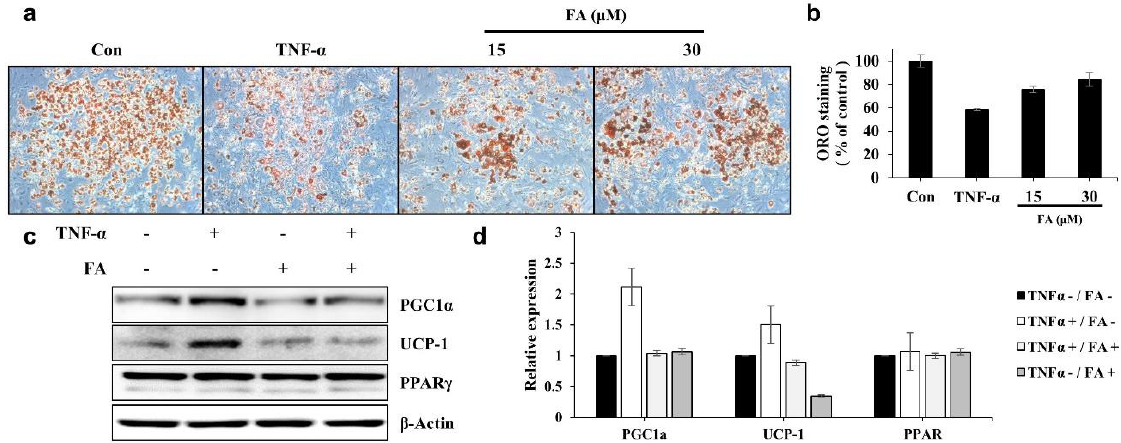
Figure 6. Farrerol (FA) reverses TNF- α induced lipid wasting in differentiated 3T3-L1 cells. ( a ) Differentiated 3T3-L1 cells were treated with TNF- α (20 ng/mL) with or without FA (15 or 30 µM) for 48 h. The representative images of the Oil Red O (ORO)-stained-cells in each indicated group are shown. ( b ) The ORO staining in the cells was dissolved in Propan-2-ol and measured. ( c ) Expression levels of PGC1a, UCP-1, and PPAR γ in differentiated 3T3-L1 cells treated with TNF- α with or without FA for 48 h were detected using Western blotting. ( d ) The expression levels of PGC1a, UCP-1, and PPAR γ are shown . Equal loading was confirmed by the quantification of β -actin. Data represent the means ± standard deviation from three independent experiments.